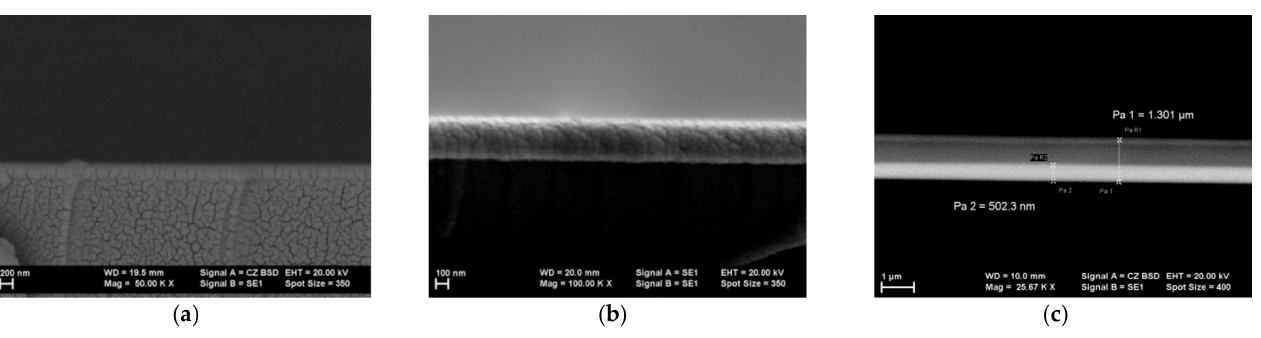
Figure 3. ( a ) As 2 S 3 thin film on the substrate; ( b ) Cu thin film on glass substrate; ( c ) heterostructure on the